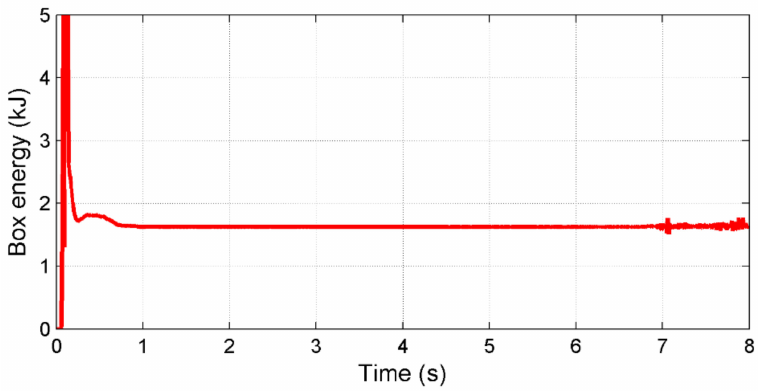
Figure 6. Energy (kJ) versus time computed within a travelling energy